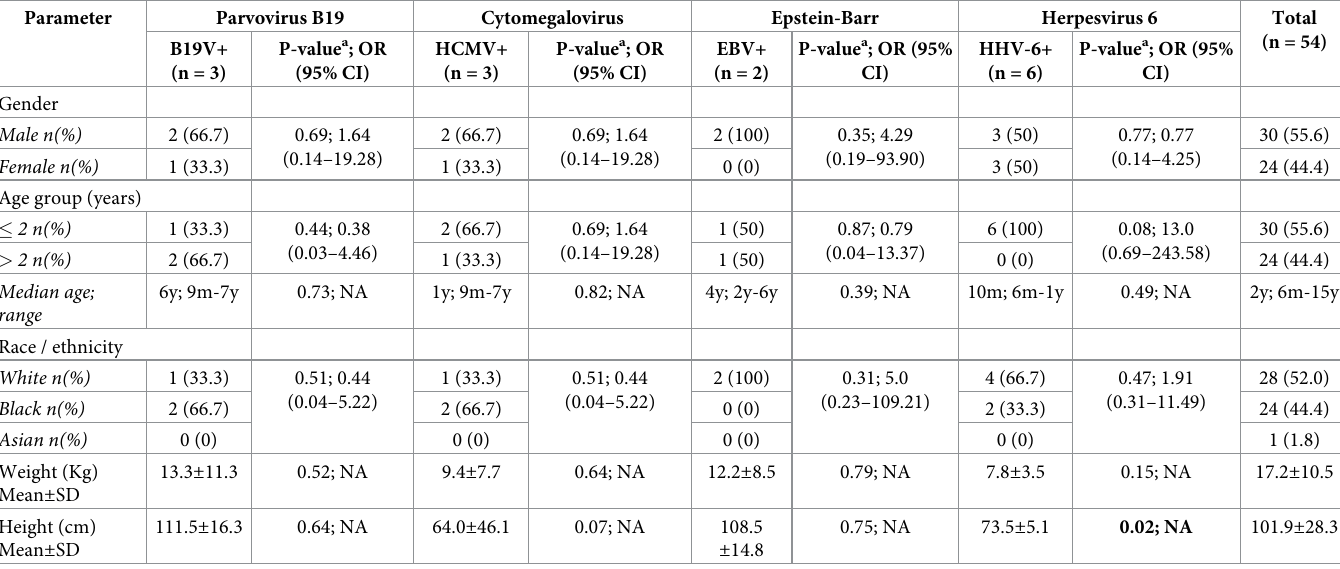
Table 1. Demographical findings among children and adolescents with rash diseases (RD).